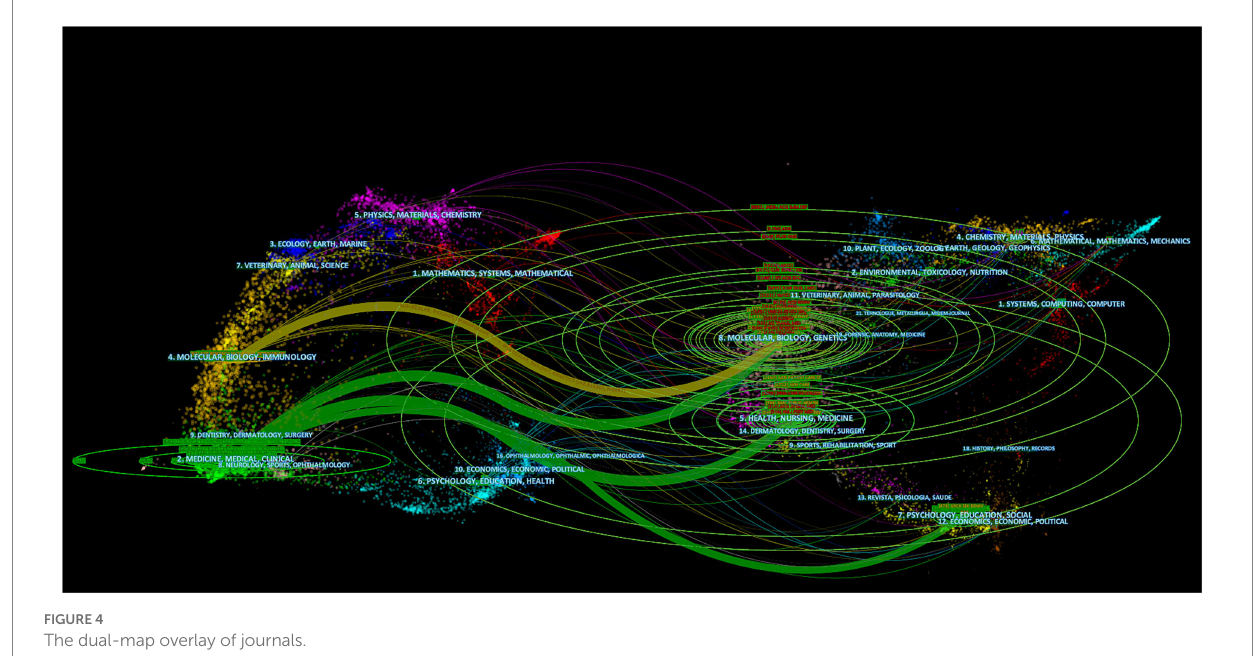
FIGURE 4 The dual-map overlay of journals.